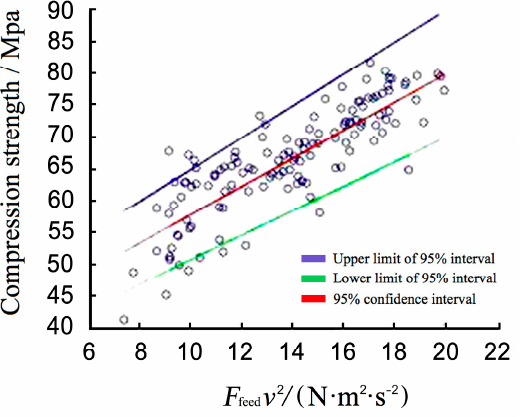
Figure 14. Correlation between wave-drag modulus and compressive strength.